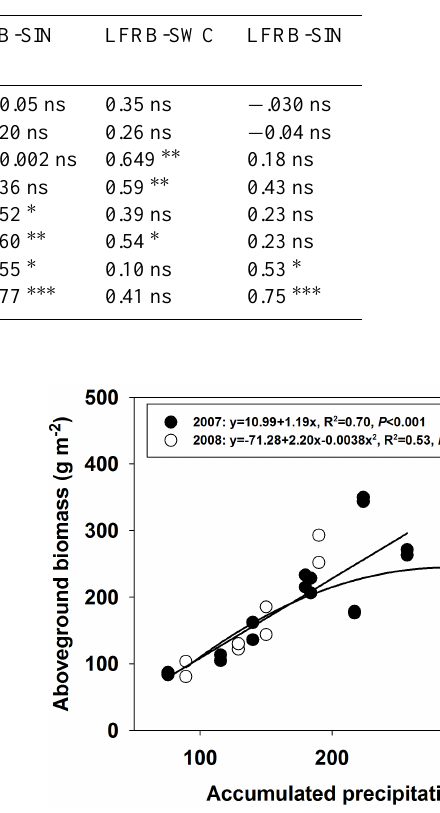
Fig. 4. The relationship between aboveground biomass and accumu- lated precipitation in 2007 (solid circles) and 2008 (open circles).